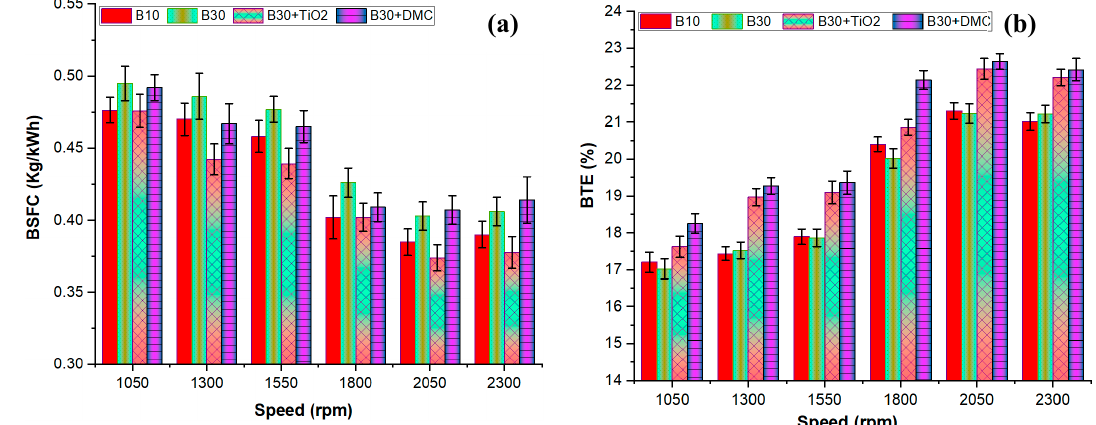
Figure 5. Variation of engine performance parameters: ( a ) brake-specific fuel consumption (BSFC) and ( b ) brake thermal efficiency (BTE) with respect to speed at 100% engine load.